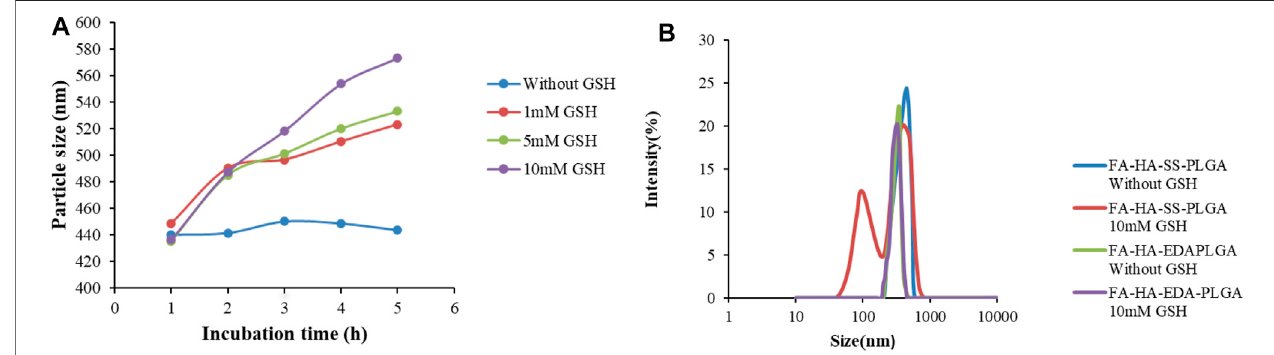
FIGURE 3 | The change in particle size and morphology of reduced sensitive FA-HA-SS-PLGA polymer with glutathione (GSH) concentration. (A) The particle size of HA-SS-PLGA in the presence of GSH (0, 1, 5, and 10 mM). (B) The particle size distribution of FA-HA-SS-PLGA and FA-HA-EDA-PLGA cultured in 10 mM GSH or without GSH for 24